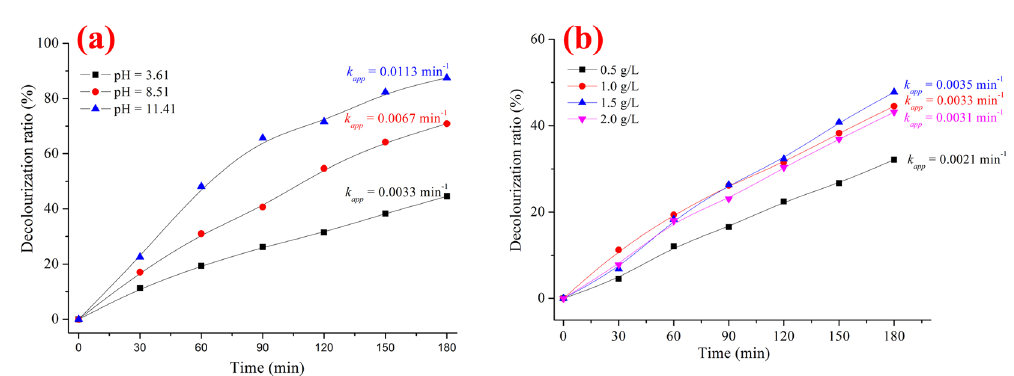
Figure 9. The decolorization ratio of MB under different ( a ) initial pH values and ( b ) concentrations of P/T(1/4).